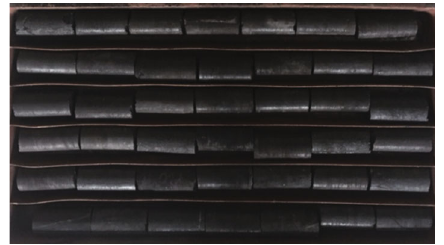
Figure 1: The coal specimen.